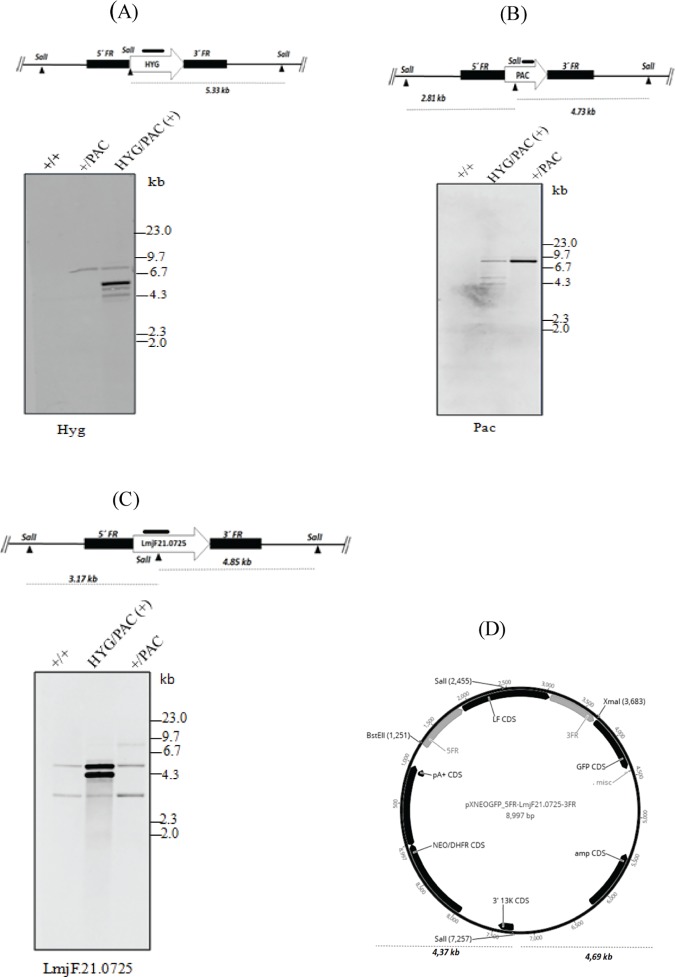
Analysis of the LmjF.21.0725 locus anatomy in wild-type and transfectants of L. major.(A)
In silico physical map of HYG replacement of the endogenous allele is depicted in the cartoon and includes SalI digestion sites (above); expected fragment size of SalI digested DNA is indicated below (interrupted line) and HYG probe fragment is depicted as coarse line above diagram. Southern blotting membrane hybridized with HYG probe is shown below. (B) The in silico physical map of PAC replacement of endogenous allele is depicted in cartoon and includes SalI digestion sites (above); expected fragment size of SalI digested DNA is indicated below (interrupted line) and PAC probe fragment is depicted as coarse line above diagram. The Southern blotting membrane hybridized with PAC probe is shown below. (C) The in silico physical map of endogenous LmjF.21.0725 allele is depicted in cartoon and includes SalI digestion sites (above); the expected 2 fragments of SalI digested DNA are indicated below (interrupted line), and the LmjF.21.0725 probe fragment is depicted as the coarse line above the diagram. The southern blotting membrane hybridized with the LmjF.21.0725 probe is shown below. (D) Map of pxNeoGFP-LmjF21.0725 used for overexpression of LmjF.21.0725, and SalI digestion predicted fragment sizes are indicated below. Leishmania wild-type (WT) and transfectants are indicated in each blot as follows: +/+ = WT; +/PAC = heterozygous line with a PAC cassette replacing one endogenous allele; +/PAC/(+): heterozygous transfectant bearing PAC and plasmid expressing LmjF21.0725 (pxNeoGFP-LmjF21.0725); PAC/HYG/(+) = double replacement transfectant with both selectable markers and plasmid expressing LmjF21.0725 (pxNeoGFP-LmjF.21.0725, addback transfectant). Marker: Lambda DNA-HindIII digested.